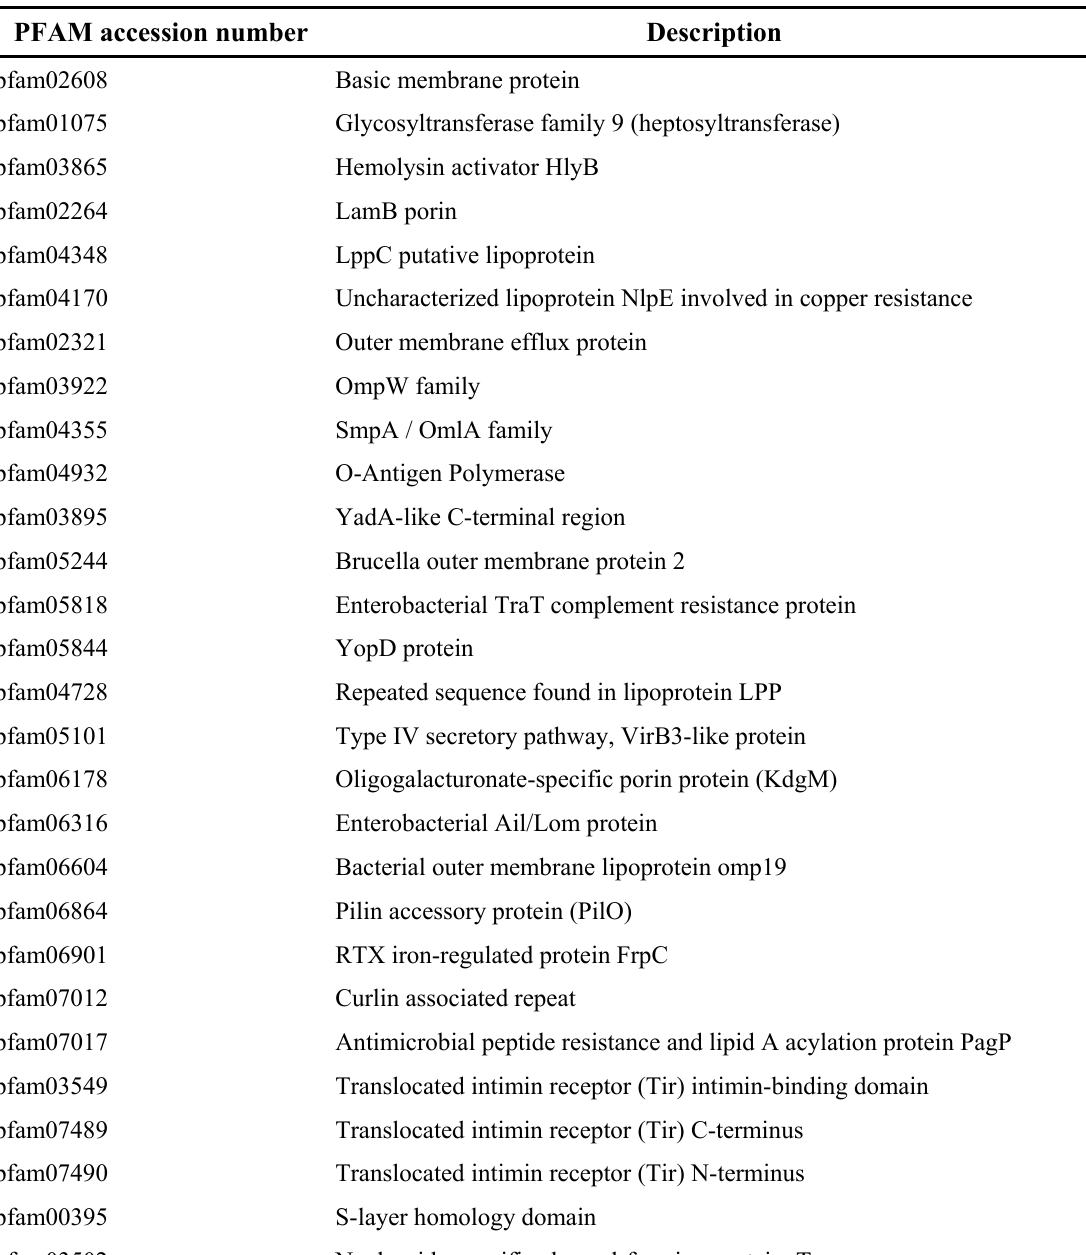
Table 6: PFAM accession numbers for outer membrane protein families in